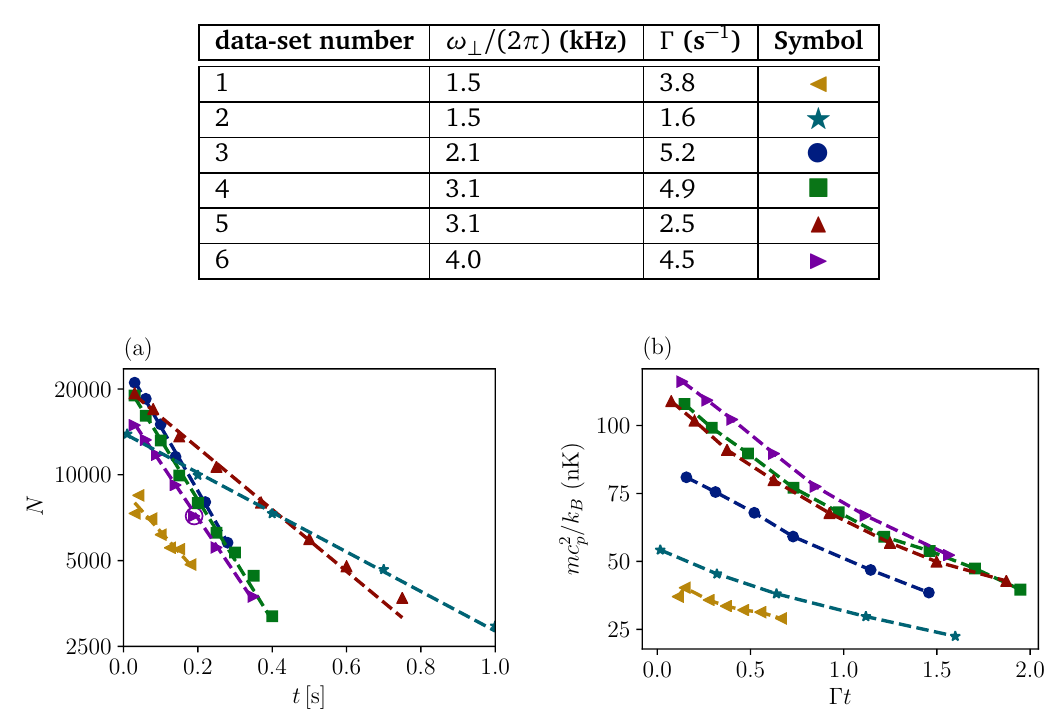
Table 1: Data sets presented in this paper, with the associated symbol used in the figures 2 and 3.